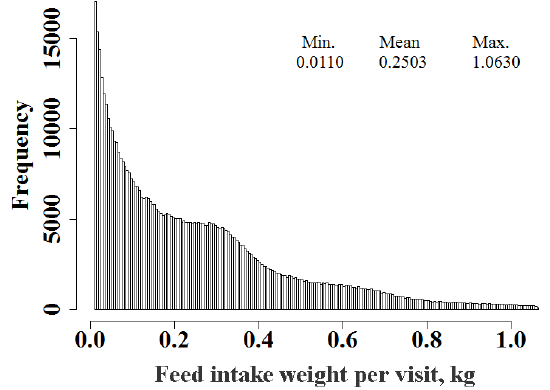
Figure A1. Histogram of feed intake weight per visit. Note: a very large proportion of results for small intake weight per visit, and a small proportion of results for large intake weight per visit. The x axis represents feed intake weight per visit (kg) and the y axis shows the frequency of feed intake weight per visit (FIWPV).